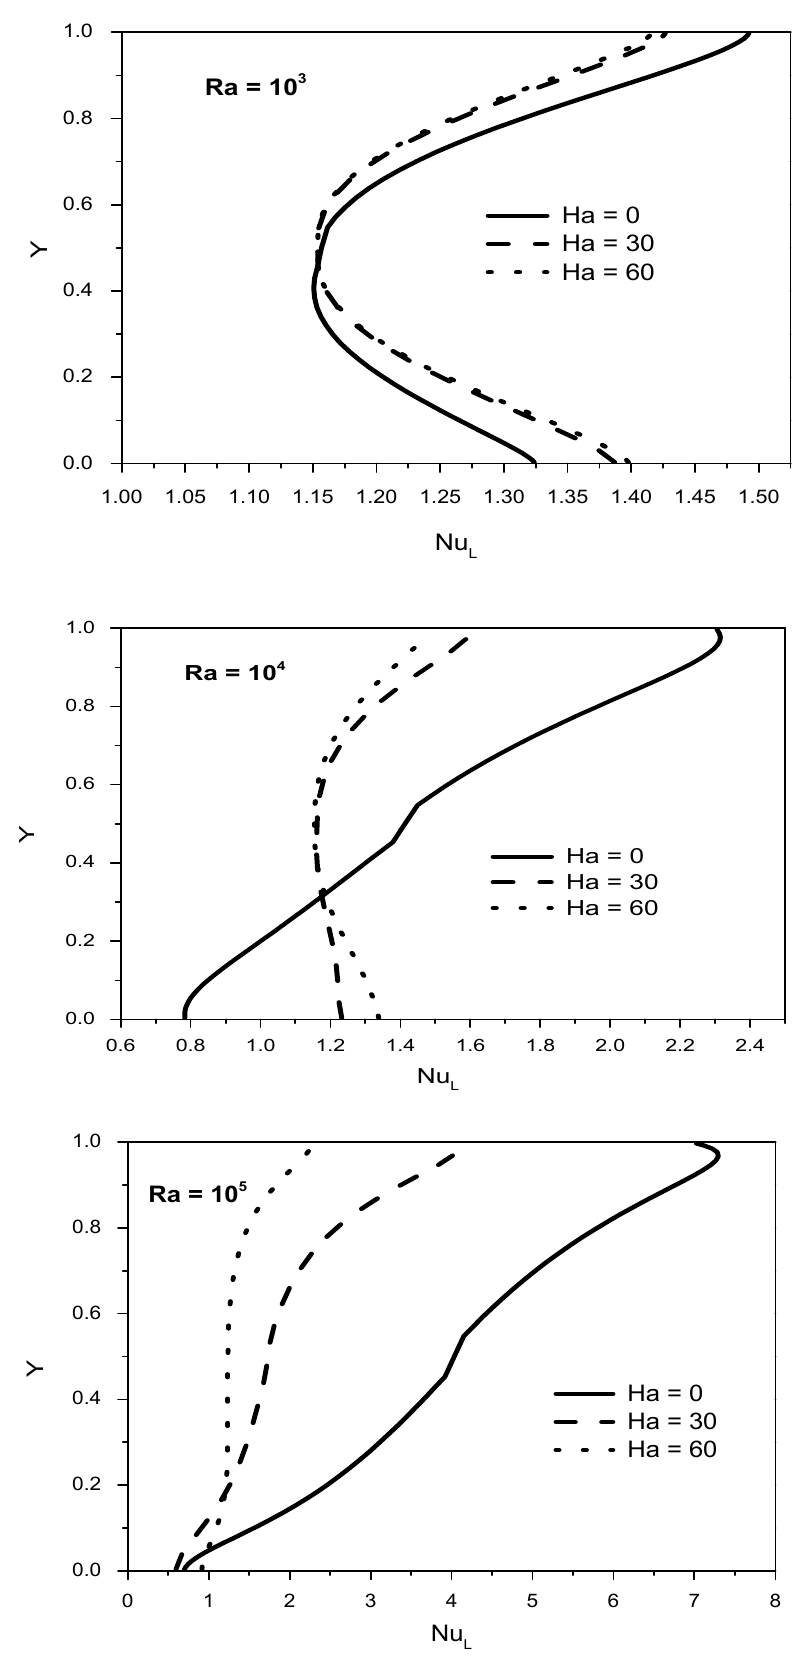
Figure 7. The variation of the local Nusselt number along the vertical axis for various values of the Rayleigh and Hartmann numbers at (d p = 10 nm and φ = 0.02). The link between the average Nusselt number and the solid volumetric fraction was depicted in Figure 8 for various Ra and Ha numbers and for (d p = 10 nm).